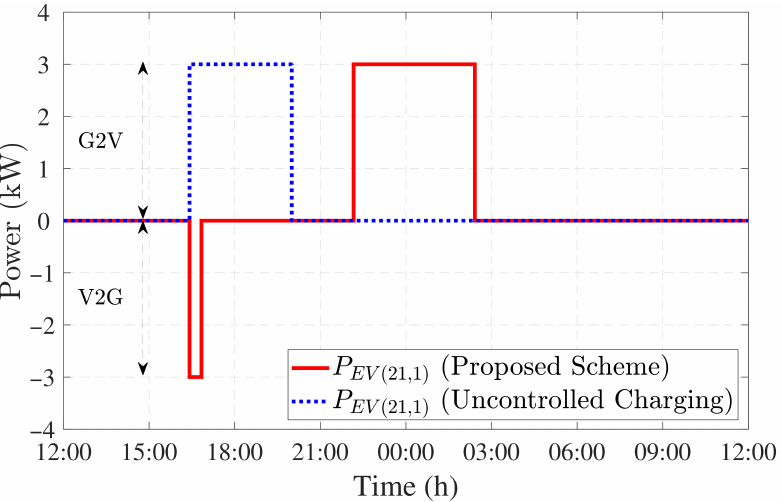
Figure 6. EV charging and discharging power